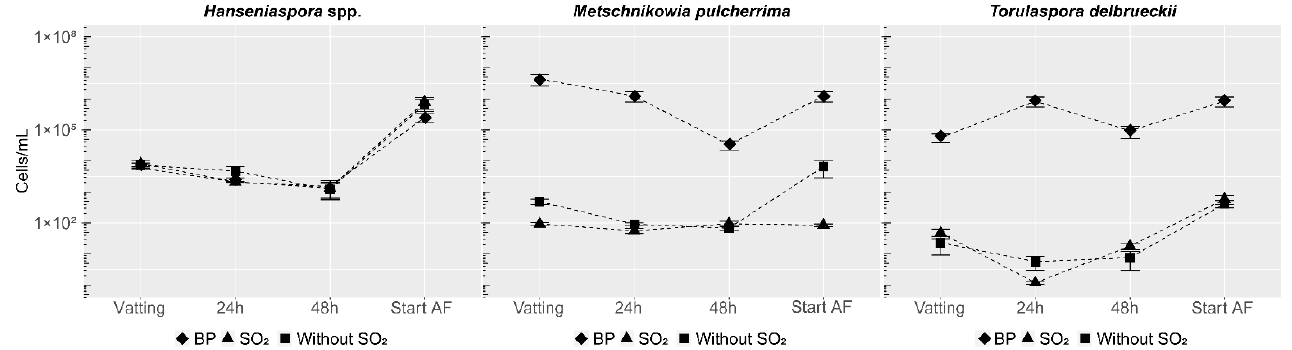
Figure 2. Population dynamics of Hanseniaspora spp., Metschnikowia pulcherrima , and Torulaspora delbrueckii . During prefermentary stages (vatting, 24 h, and 48 h of maceration, start of alcoholic fermentation). Bioprotection (BP), SO 2, and without SO 2 treatments. Values indicated as the mean of four technical replicates ± standard deviation.